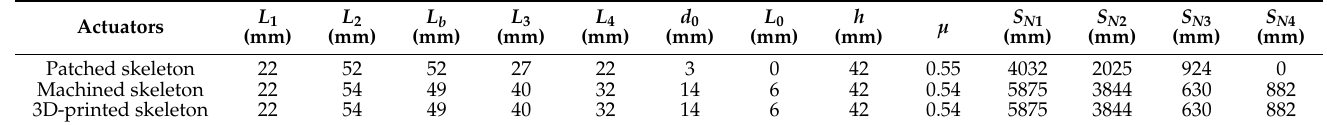
Table 1. Basic parameters of different